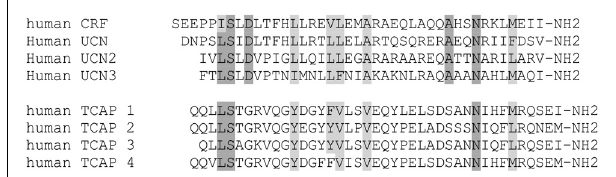
FIGURE 2 | Comparison of the primary structure between the TCAP and CRF families of peptides. Amino acid identity among CRF paralogs are shown as dark gray, and continued among TCAP peptides where they match. Conservative homologous substitutions are shown in light gray. Note that the identity among TCAP peptides is much greater than that of CRF